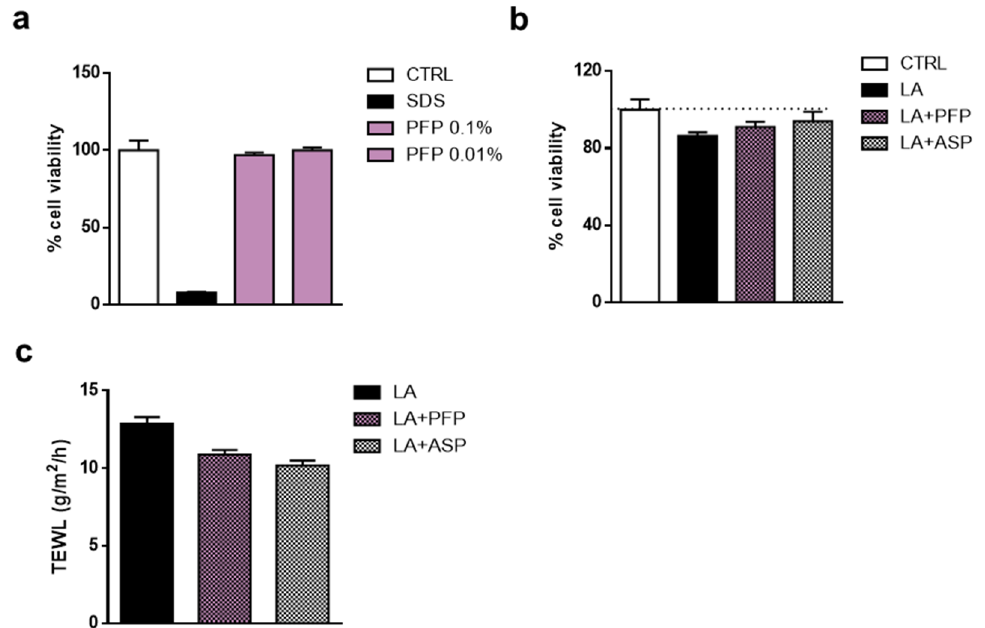
Figure 10. Analysis of ( a ) irritant, ( b ) soothing and ( c ) hydration activities of PFP 0.1% solution in an in vitro model of reconstructed vaginal mucosa. SDS 0.5% and lactic acid (LA) 0.4% solutions were used as irritant controls; acetylsalicylic acid (ASP) 0.03% solution was used as an active control agent. Data are expressed as mean ± SD of two independent experiments ( n = 2).